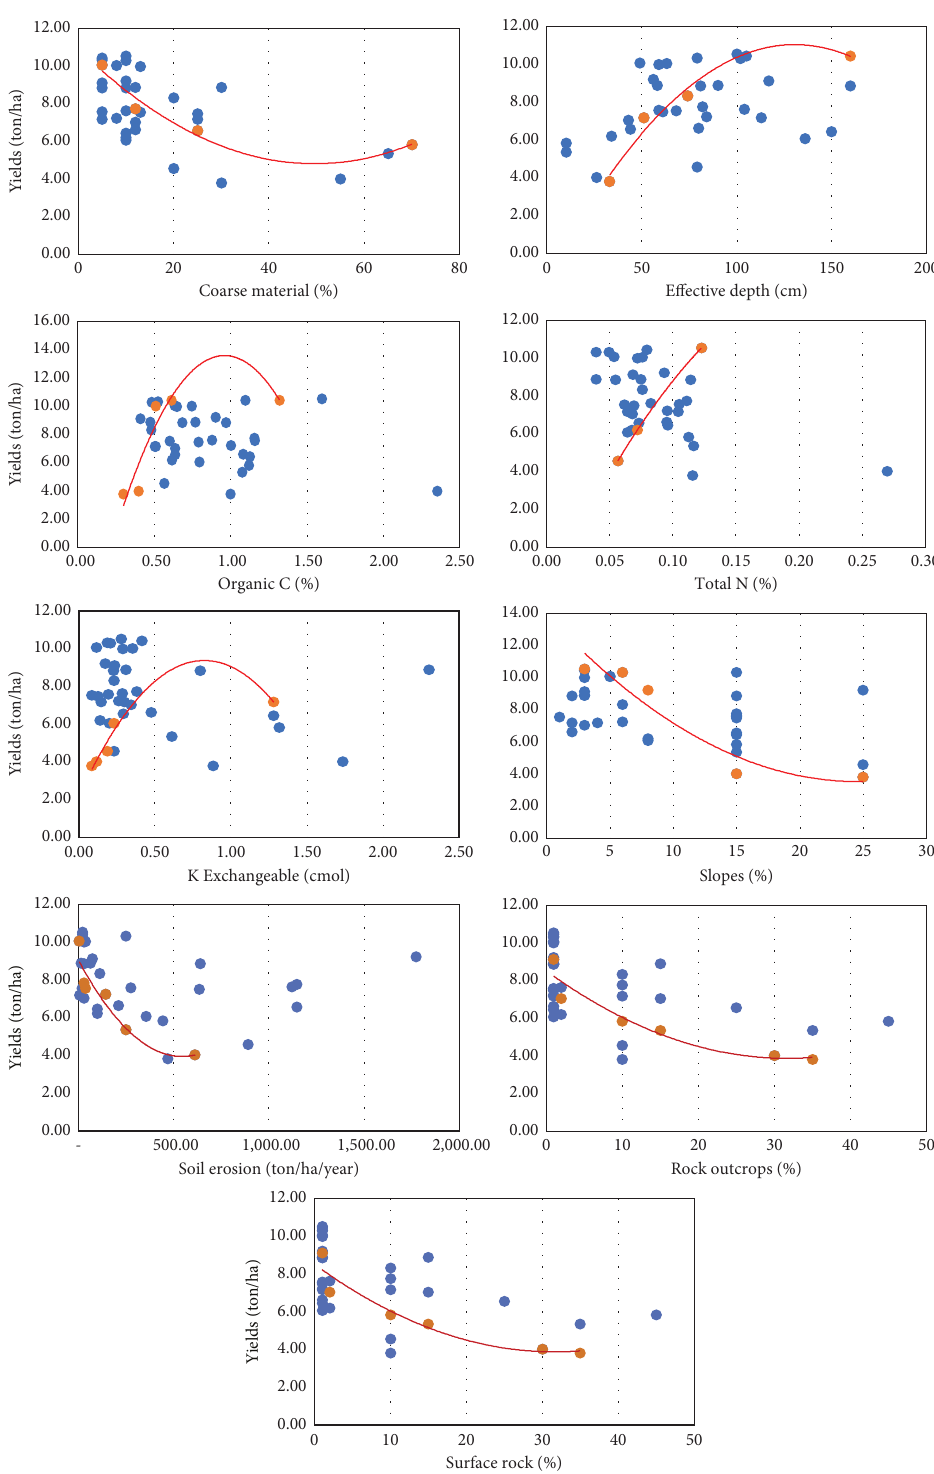
Figure 4: Scatter diagram relationship among maize yield and land